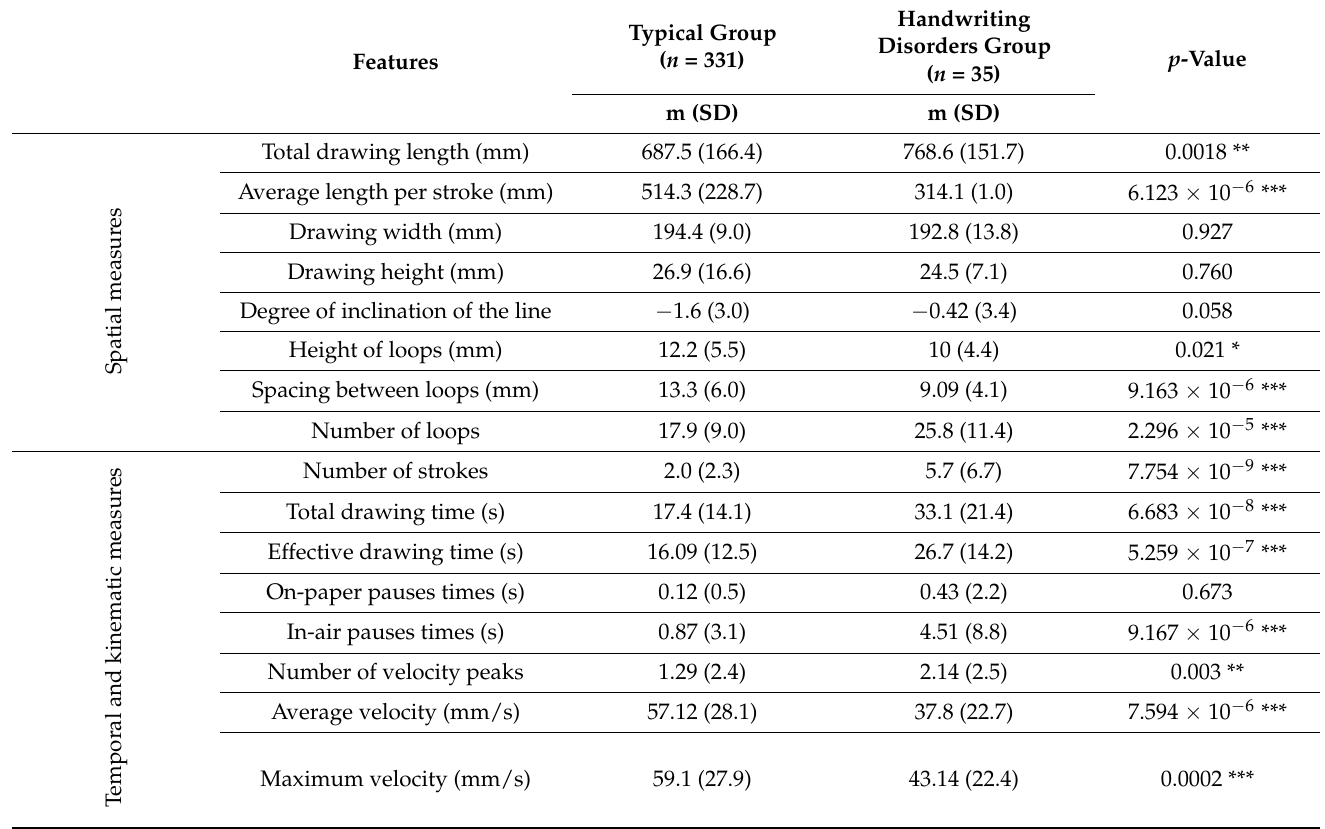
Table 3. Mean (SD) of spatial, temporal, and kinematic measures for the handwriting disorders group compared to a typical sample instructed to copy a line of cycloid